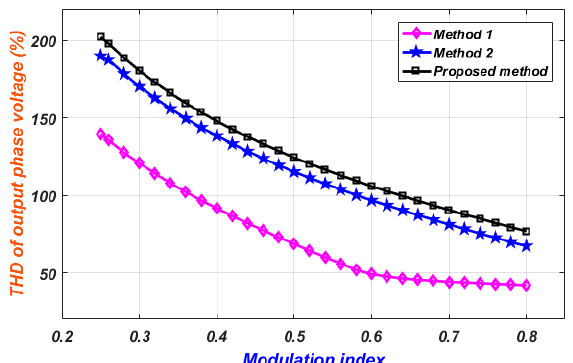
Figure 8. Total harmonic distortion (THD) of output phase voltage ( V AG ) under different modulation indexes.